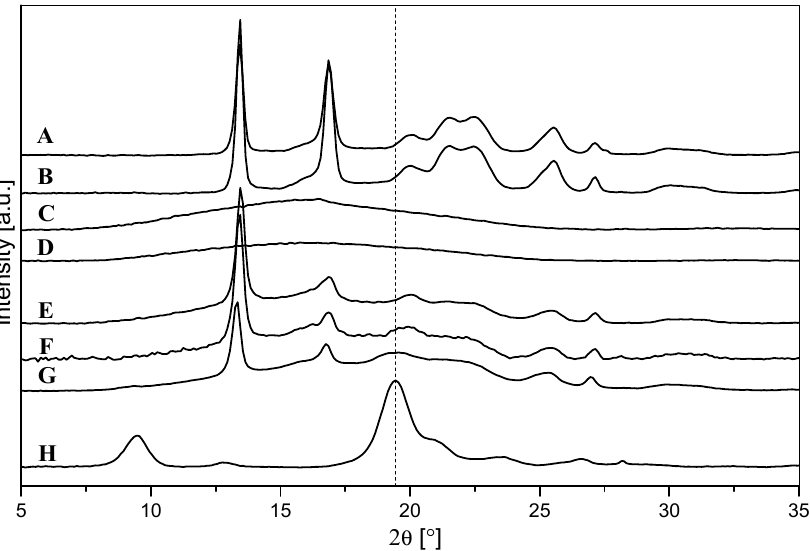
Figure 5. FTIR spectra in the 1850–700 cm − 1 region of ( A ) PLA, ( B ) PLA/TB, ( C ) PHB, ( D ) PHB/TB, ( E ) PLA/PHB, ( F ) PLA/PHB/TB, and ( G ) PLA/PHB/TB/ChNP. Inset: FTIR spectra in the 1670–1300 cm − 1 region.